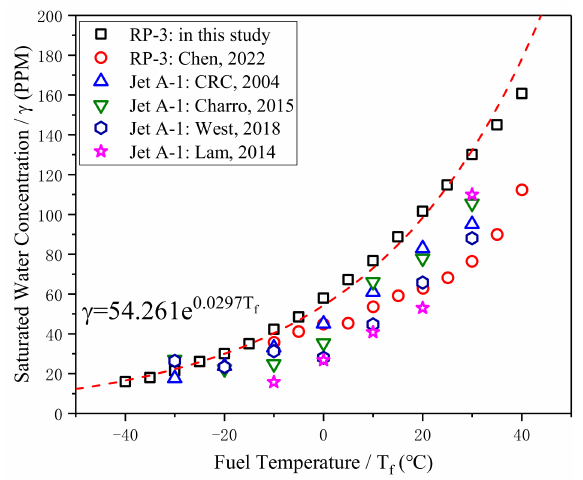
Figure 9. The saturated water concentration of fuel temperature. The red line represented the fitting line of experimental data in this study. Other experimental data were from literature